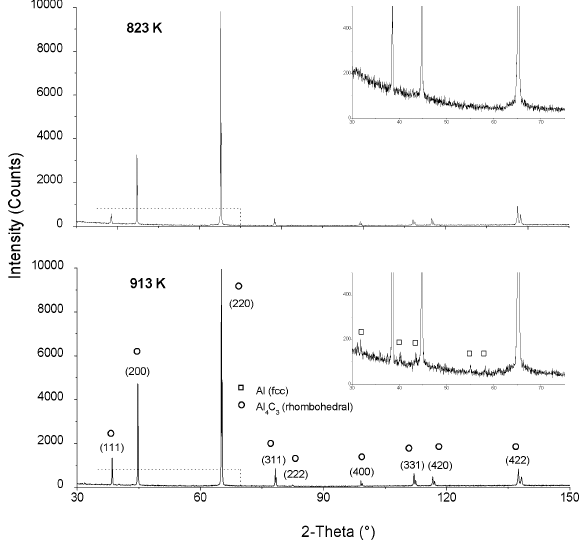
Figure 1. X-ray diffraction patterns of Al-4 vol. % Al 4 C 3 composite annealed at 823 K and 913 K for 100 h.